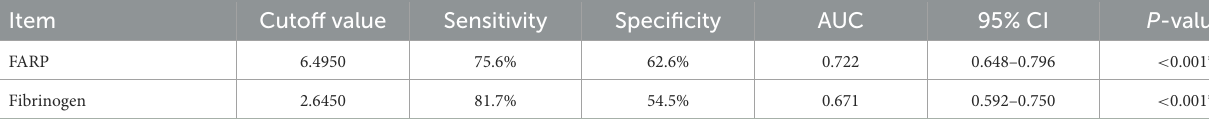
TABLE 8 ROC curve analysis of the prediction of disease severity based on FARP. Item